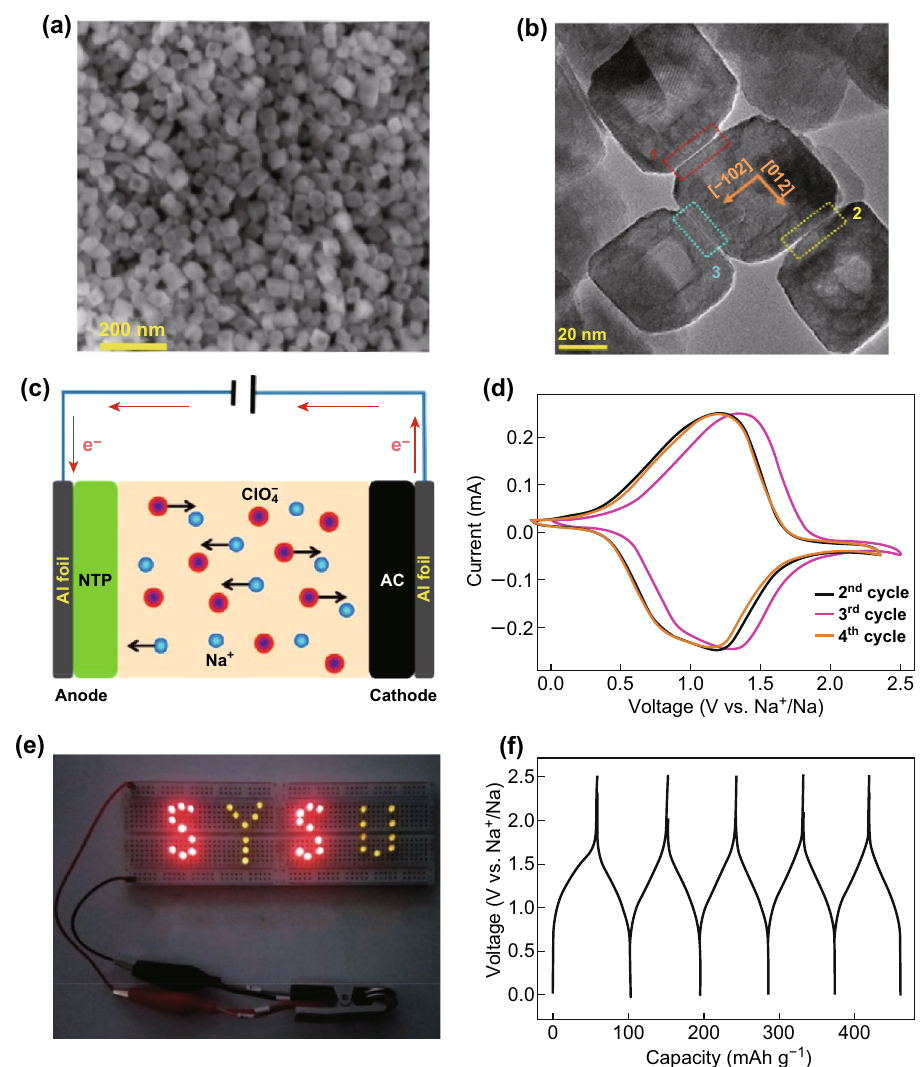
Fig. 14 a SEM and b TEM images of the obtained mesoporous NTP nanocages. c Schematic illustration of the operating mechanism of an NHC. d Photograph of a logo consisting of 35 LEDs powered by two NHCs in series. e , f CV curves and charge–discharge profiles of the sodium-ion capacitor [221]. Copyright 2017, American Chemical